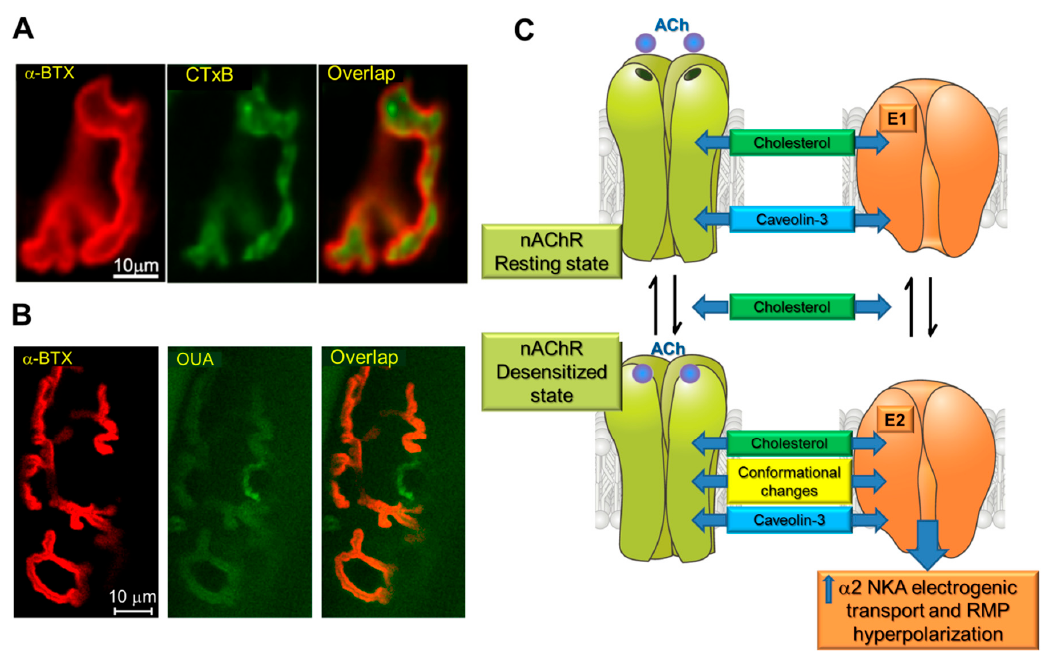
Figure 2. Cholesterol as a part of nAChR/ α 2Na,K-ATPase multimolecular regulatory complex. ( A ) The nAChRs and lipid rafts reside at the endplate region. A single endplate of rat soleus muscle was dual-labeled with α -BTX (nAChRs, red channel) and fluorescent cholera toxin B subunit to stain lipid rafts (CTxB, green channel). Overlap (orange channel). ( B ) The nAChR and the α 2 Na,K-ATPase colocalization at the muscle endplate. A single endplate of mouse extensor digitorum longus muscle was dual-labeled with α -BTX (nAChRs, red channel) and BODIPY-conjugated ouabain ( α 2 Na,K-ATPase, green channel). Overlap (orange channel). Scale bars, 10 µ m. ( C ) Hypothetical scheme of nAChR/ α 2Na,K-ATPase/Caveolin-3/Cholesterol interactions stimulating electrogenic active transport to hyperpolarize the resting membrane potential (RMP). Modified from Petrov et al. (2017) ref. [120] (A) and Heiny et al. (2010) ref. [100] (B).